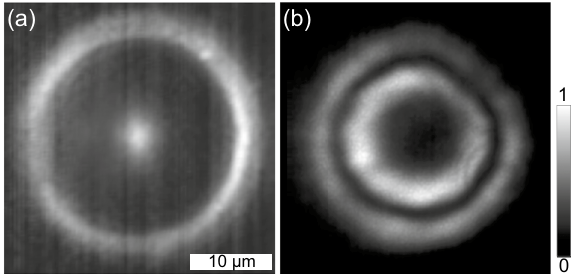
Figure 1. Real-space images of PL of the sample under the non-resonant optical pump below ( a ) and above ( b ) the polariton condensation threshold. In ( a ) the central peak and the outer ring are the luminescence from the laser-induced exciton reservoir and from the edge of the pillar due to scattering, respectively. In ( b ) the double ring intensity pattern corresponds to PL from the mesoscopically occupied state of the exciton polariton